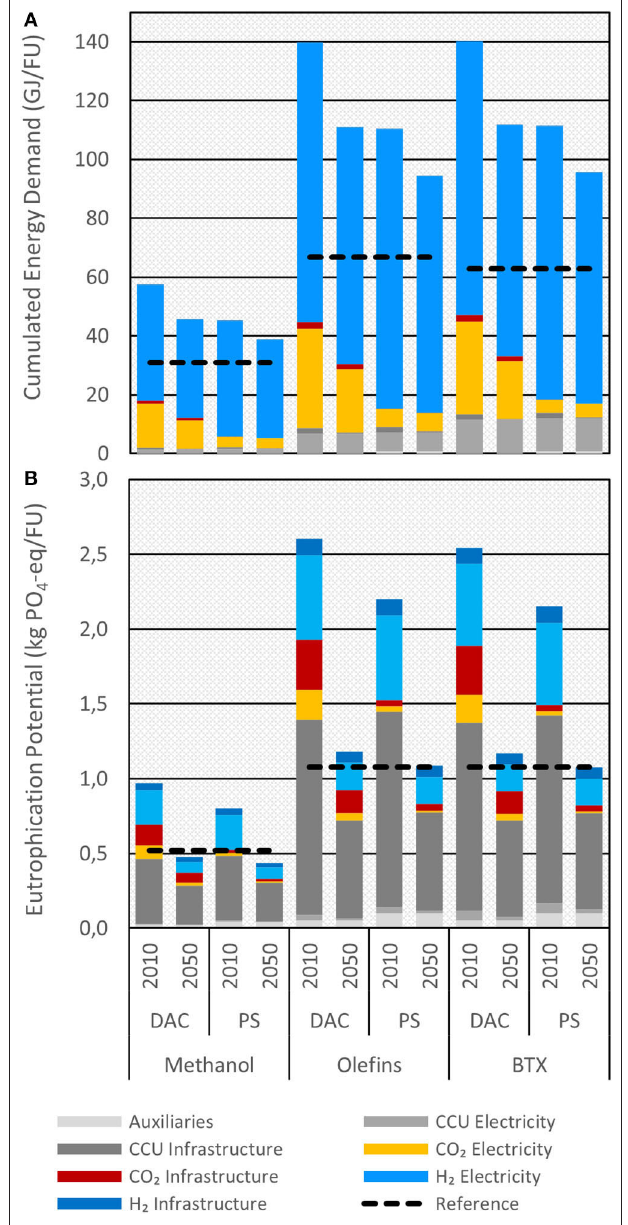
FIGURE 5 | Cumulated energy demand (A) and eutrophication potential (B) for methanol, olefins and BTX from CCU production compared to the respective fossil references. Results for AP, ODP, and PM 2.5 can be found in the